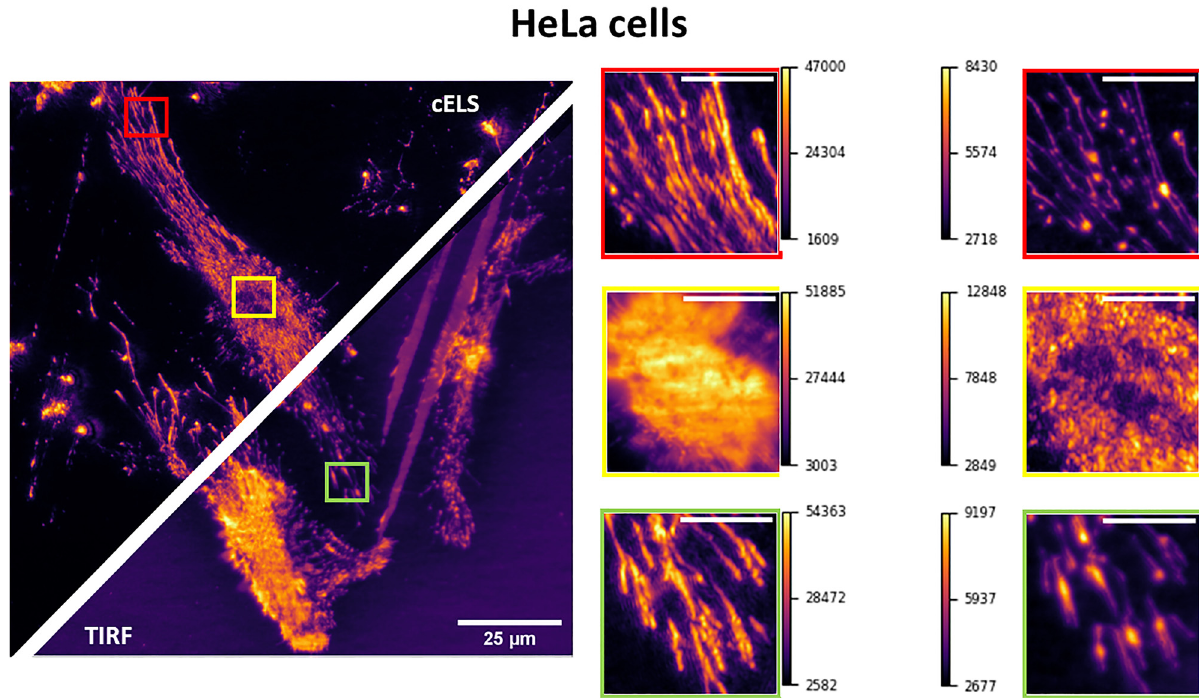
Figure 6: Comparison between cELS and TIRF images of Hela cells, scale bar 25 μ m. Three different regions of interest enclosed by red, yellow, and green boxes are blown-up and provided alongside. The yellow box shows the nucleus region of the cell whereas the red and green boxes are the filaments, scale bar 8 μ m. The color bars given alongside the magnified regions indicate the pixel